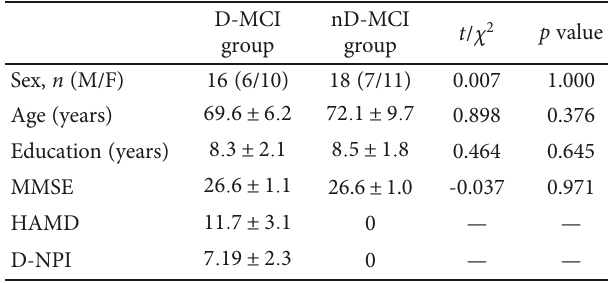
Data represent the mean ± SD . Data were analysed using independent sample t -tests. D-MCI: mild cognitive impairment with depression; nD-MCI: nondepressed mild cognitive impairment; M: male; F: female; MMSE: Mini-Mental State Examination; D-NPI: depression domain of Neuropsychiatric Inventory; HAMD: Hamilton Depression Rating